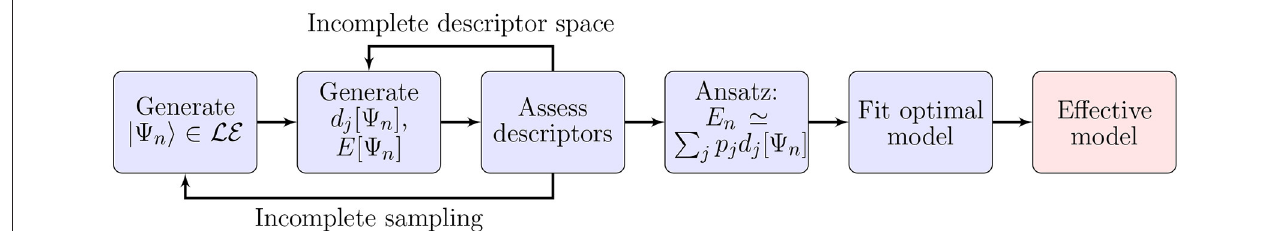
FIGURE 1 | A practical protocol for fitting effective models to ab initio